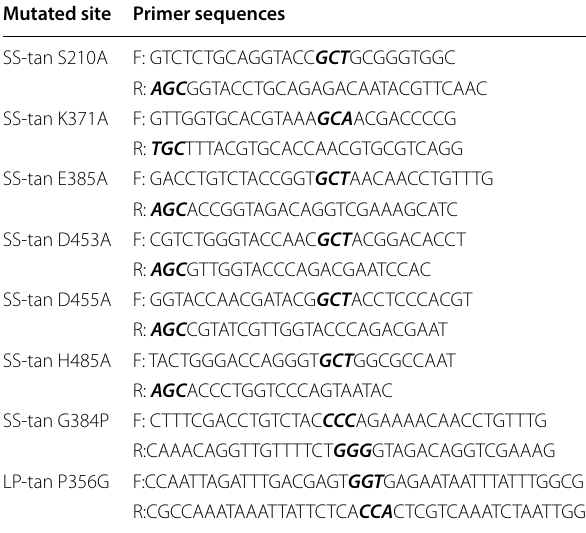
The mutated nucleotide sites are indicated by bolditalics